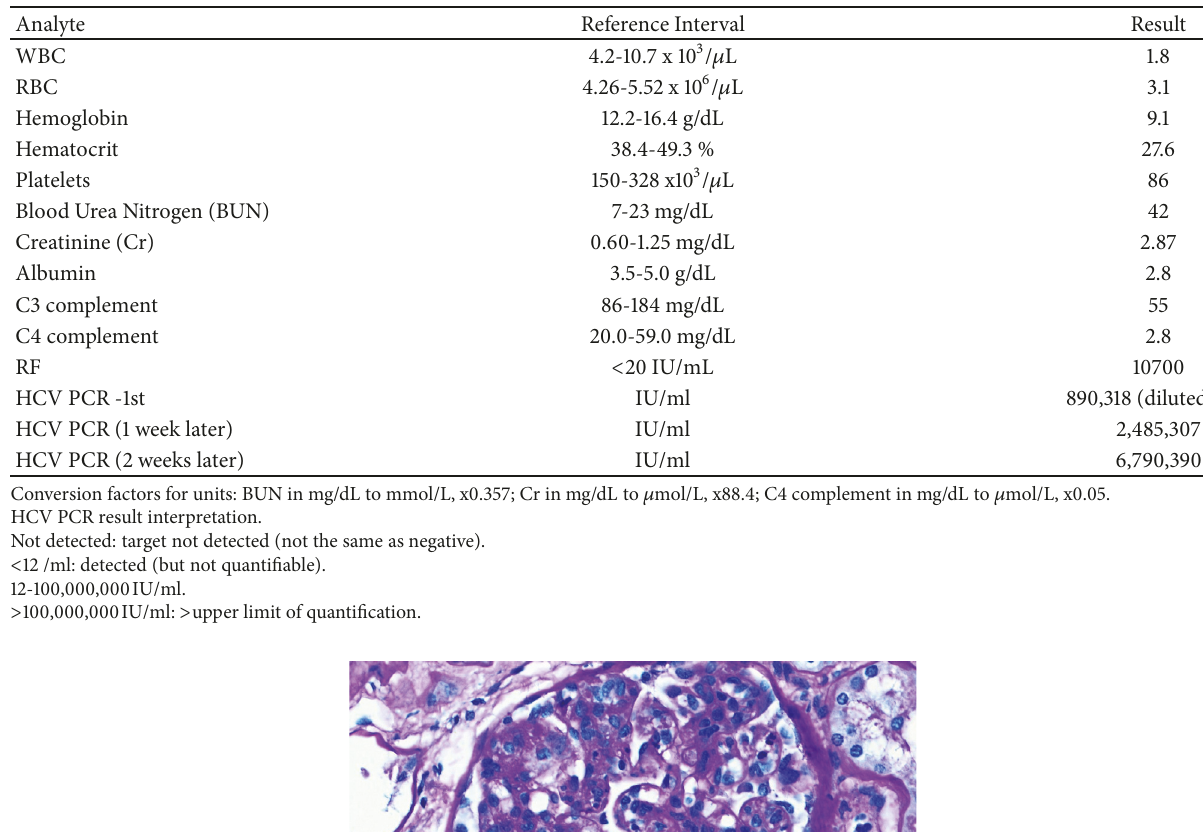
Table 1: Patient’s lab results on presentation.